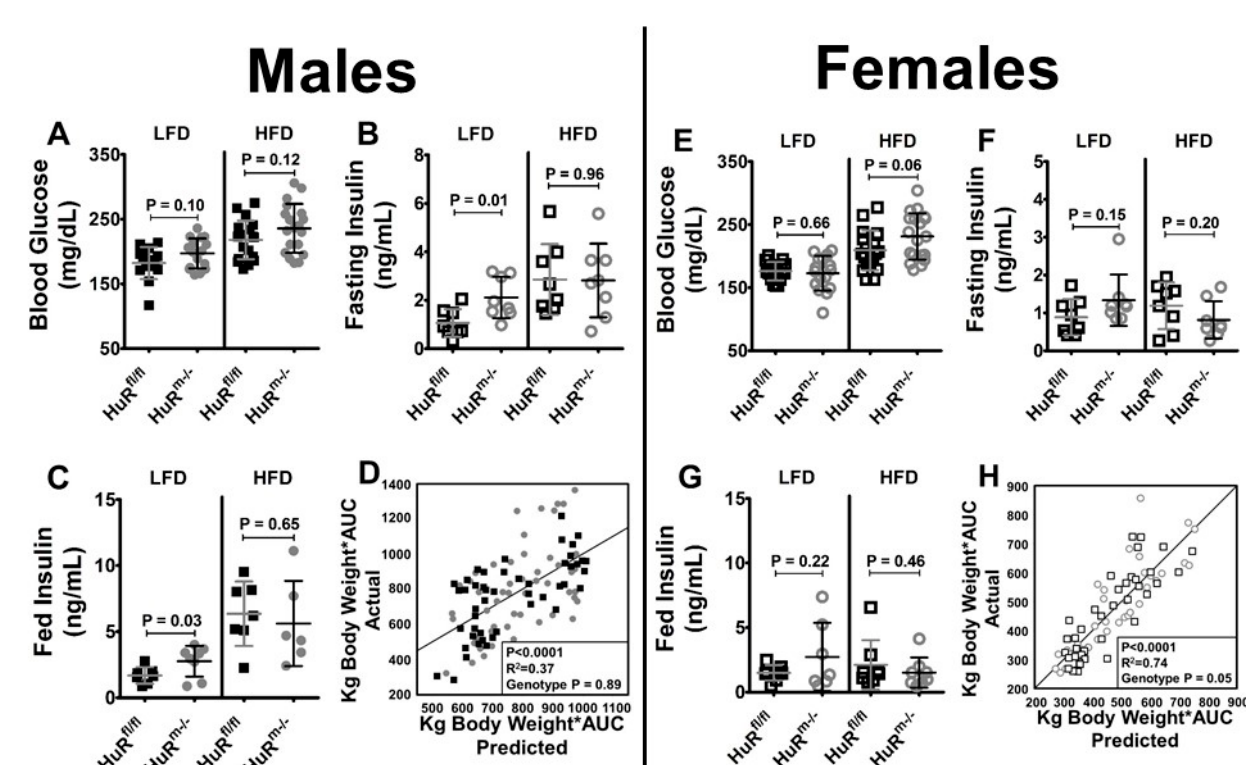
Figure 4. Increased fat mass drives decreased glucose clearance relative to controls in HuR m − / − males only ( A ) Fasted blood glucose levels at 20 weeks of age for male control (black) or HuR m − / − (grey) mice fed either LFD or HFD ( n = 14–19). ( B ) Fasted serum insulin levels at 20 weeks of age for male control (black) or HuR m − / − (grey) mice fed either LFD or HFD ( n = 8). ( C ) Fed serum insulin levels at 20 weeks of age for male control (black) or HuR m − / − (grey) mice fed either LFD or HFD ( n = 7–8). ( D ) ANCOVA analysis showing the contribution of genotype to decrease in glucose clearance for male control (black) or HuR m − / − (grey) mice as fat mass increases. ( E ) Fasted blood glucose levels at 20 weeks of age for female control (black) or HuR m − / − (grey) mice fed either LFD or HFD ( n = 16–19). ( F ) Fasted serum insulin levels at 20 weeks of age for female control (black) or HuR m − / − (grey) mice fed either LFD or HFD ( n = 8). ( G ) Fed serum insulin levels at 20 weeks of age for female control (black) or HuR m − / − (grey) mice fed either LFD or HFD ( n = 7–8). ( H ) ANCOVA analysis showing the contribution of genotype to decrease in glucose clearance for female control (black) or HuR m − / − (grey) mice as fat mass increases.